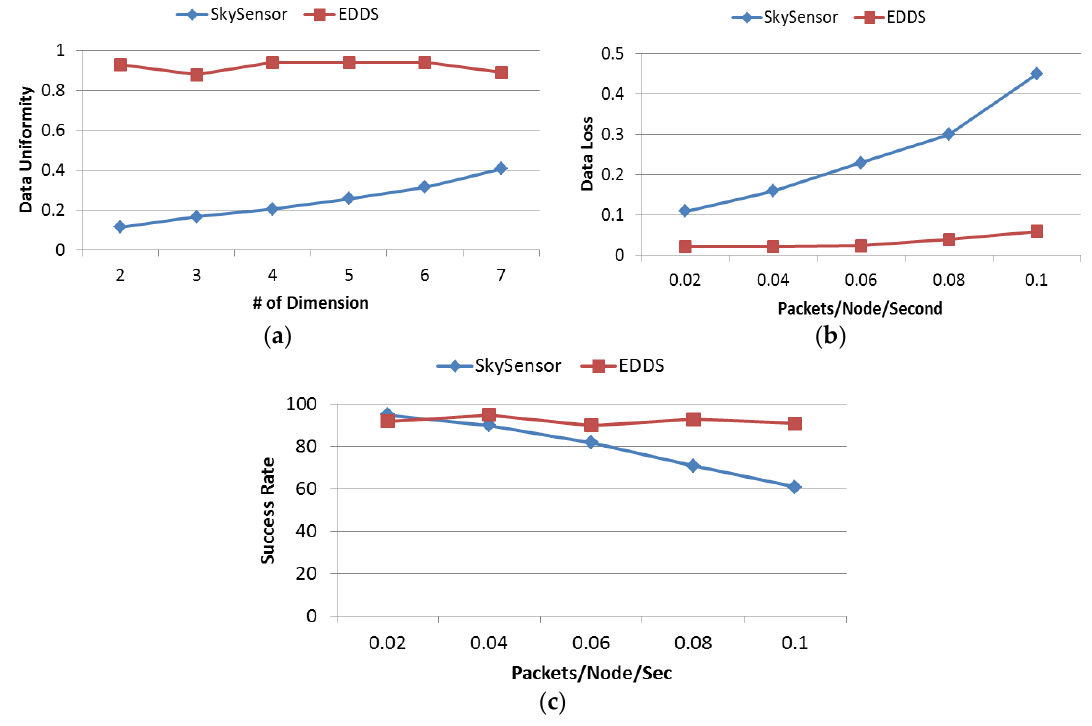
Figure 16. ( a ) Data uniformity; ( b ) data loss; and ( c ) success rate.